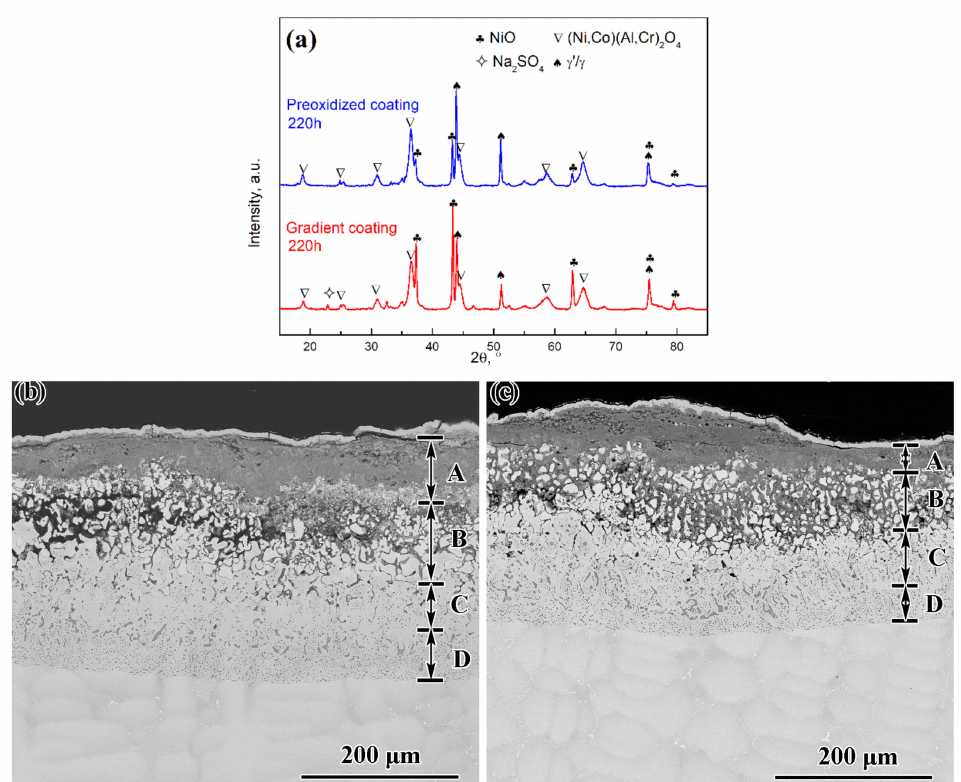
Figure 8. Surface XRD patterns and cross-sectional BSE images of the gradient and preoxidised coatings after the hot corrosion test for 220 h: ( a ) XRD patterns of the two coatings; ( b ) the gradient coating; ( c ) the preoxidised coating. A zone: a thick, non-protective mixed oxide scale; B zone: consisting of isolated Ni-rich alloy islands and net-like corrosion products; C zone: internal oxidation formed by Al and O; D zone: internal sulphidation formed by Cr and